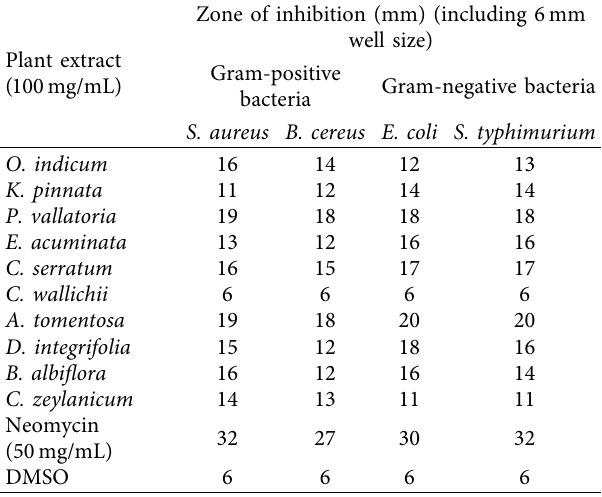
Table 5: In vitro antimicrobial activity of plant extracts against diferent bacterial strains.